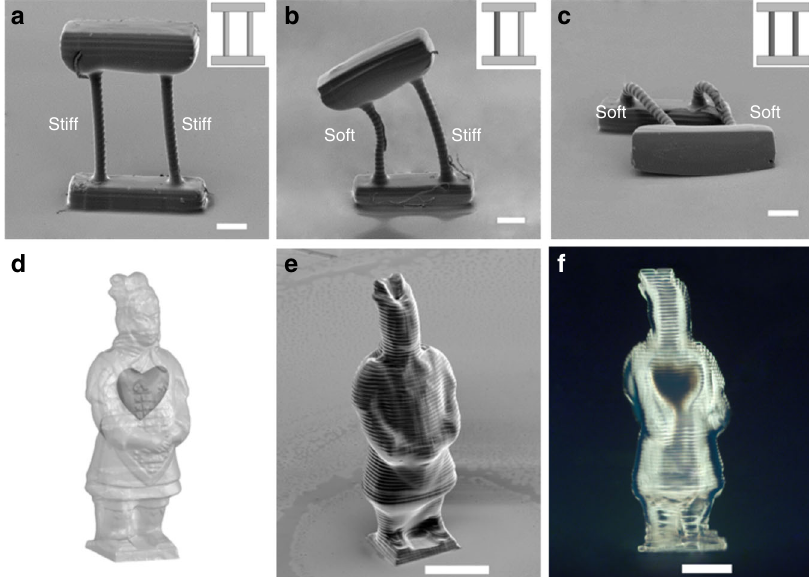
Fig. 3 Orthogonally programmed stiffness and geometry in 3D-printed overhang structures. A beam was hold by two supporting rods, which were printed with the same geometry (diameter: 80 μ m; height: 0.9 mm) but three different stiffness combinations, i.e. a stiff/stiff, b soft/stiff, and c soft/soft (stiff with